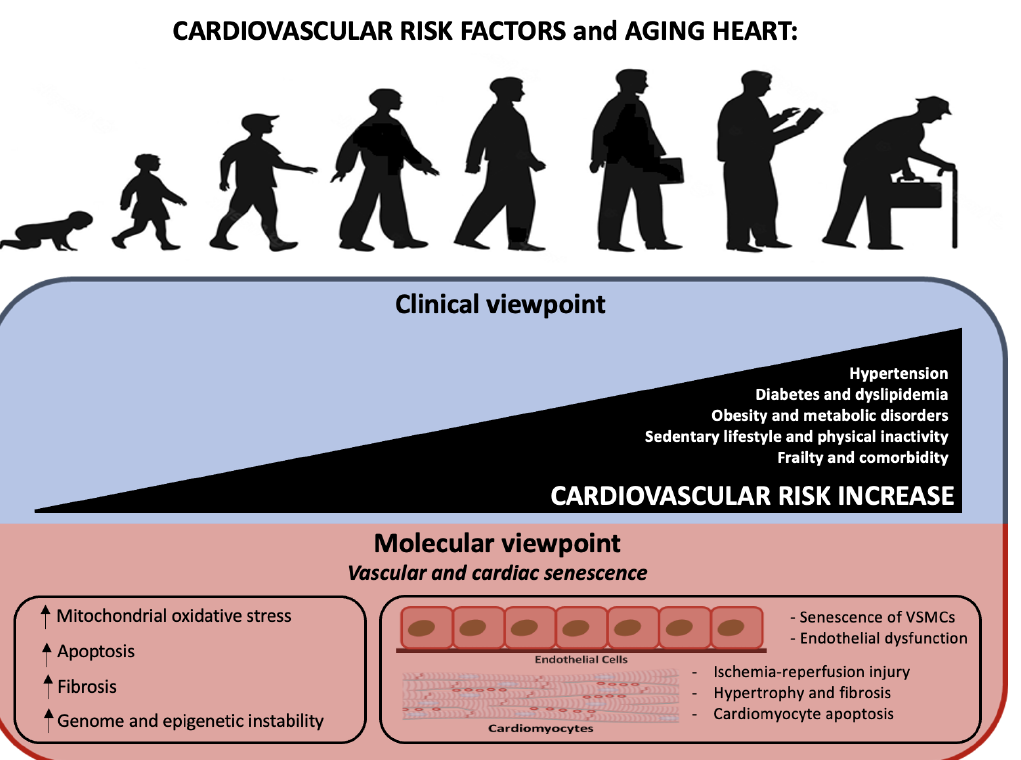
Figure 2. Aging heart and cardiovascular risk: from clinical to molecular viewpoint. The upper figure shows the correlation between age and CV risk, which is explained by an increase in the number of pathologies such as diabetes and dyslipidemia. Underneath, the same events are explained from a molecular point of view.